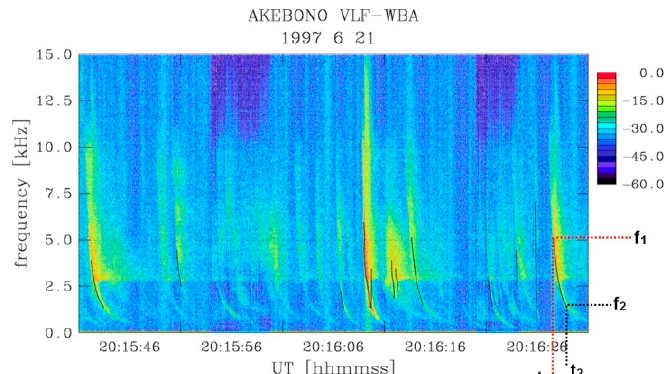
Figure 1. An example of a frequency–time spectrum of a lightning whistler observed on 21 June 1997, from AKEBONO, with the marked lightning whistler detected using the 1/ √ f conversion technique (image source [15]).